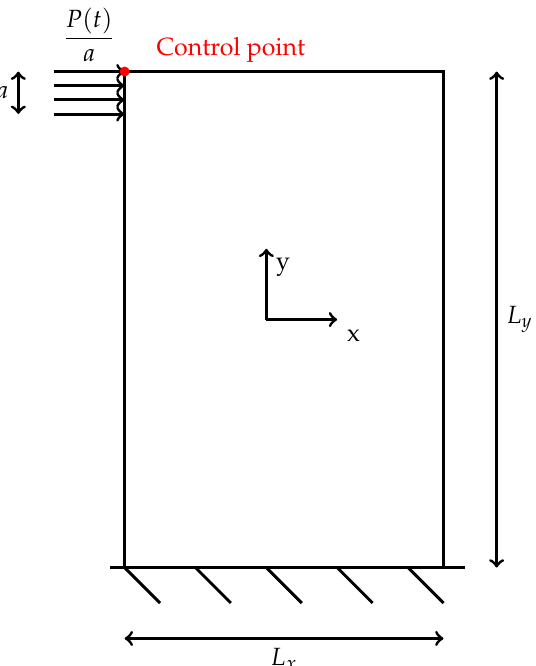
Figure 3. Schematic of the panel